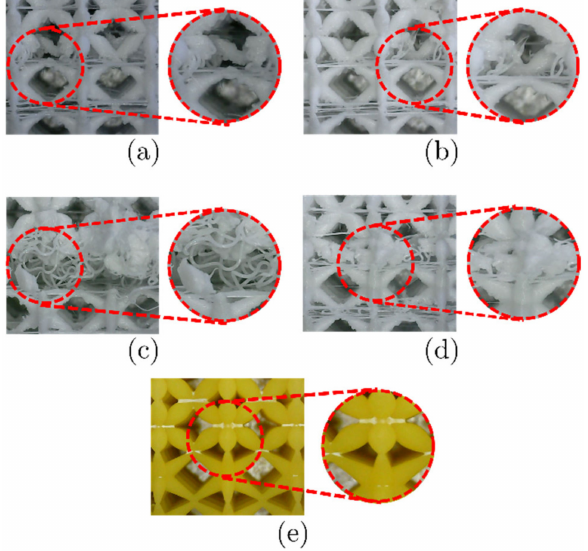
Figure 14. Print defects in LLS with PS and COS unit cells: ( a ) no connection in struts, ( b ) absence of struts, ( c ) absence of unit cells, ( d ) accumulation of material, and ( e ) connection in LCD